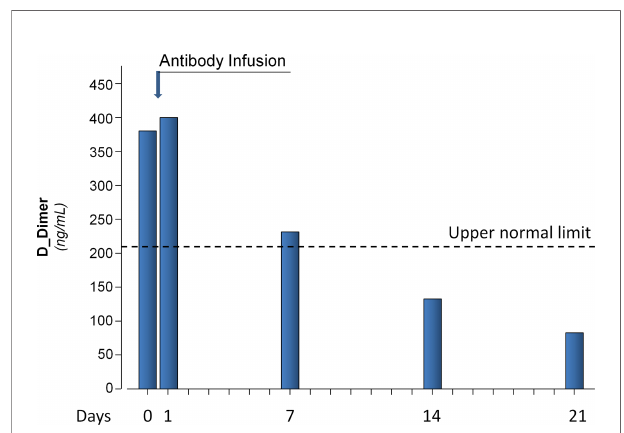
FIGURE 4 | D-Dimer levels in patient plasma samples collected before antibody infusion (Day 0) and 1, 7, 14, and 21 days thereafter. Dashed line represents the upper normal